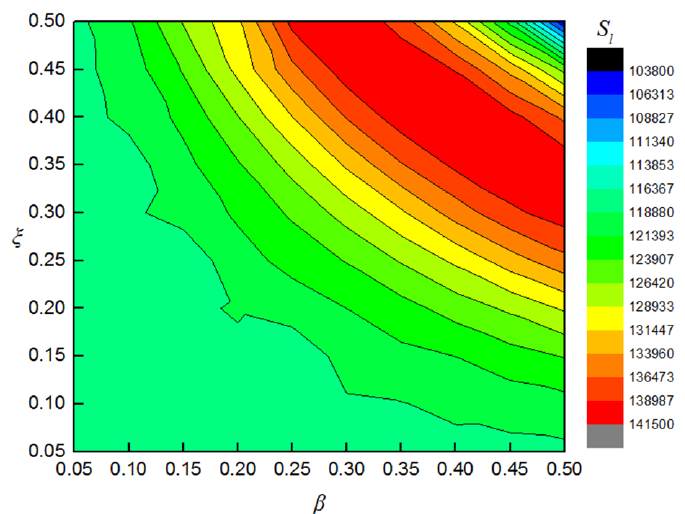
Figure 15. Variation in index S l with β and ξ . Table 2. Values of S s and S l under different crack parameters.